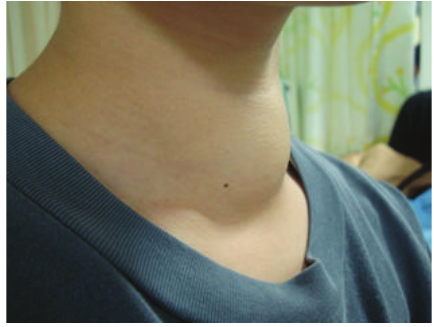
Figure 1: Anterior neck swelling without pain or redness.